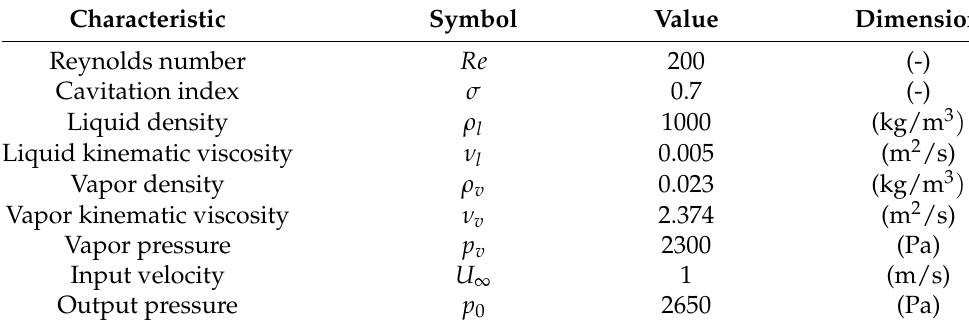
Table 6. Fluid data considered in simulations.